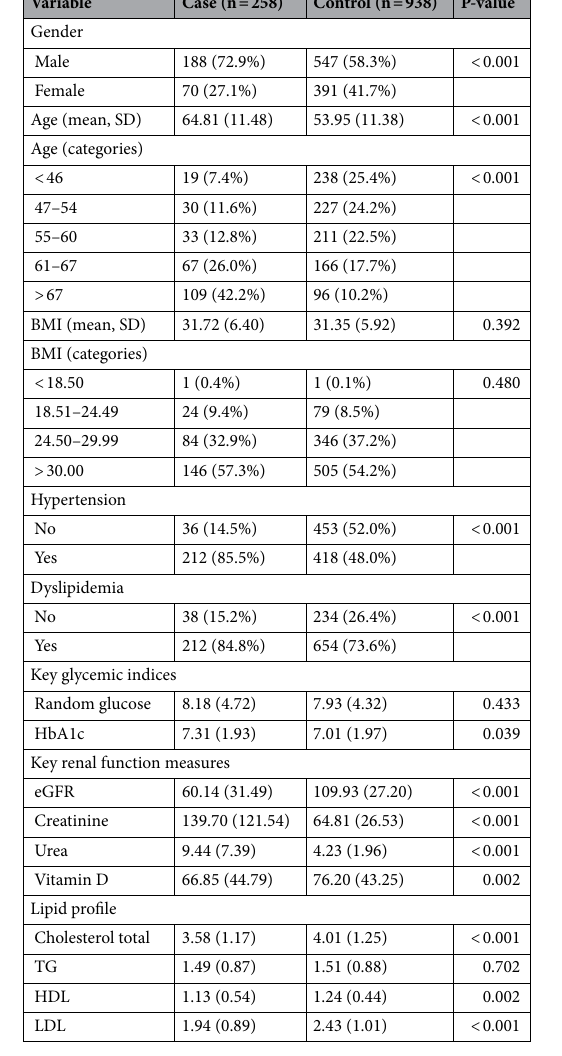
Table 1. Demographic data of the study participants. eGFR: estimated glomerular filtration rate; HDL: high- density lipoprotein; LDL low-density lipoprotein; SD: standard deviation; TG: